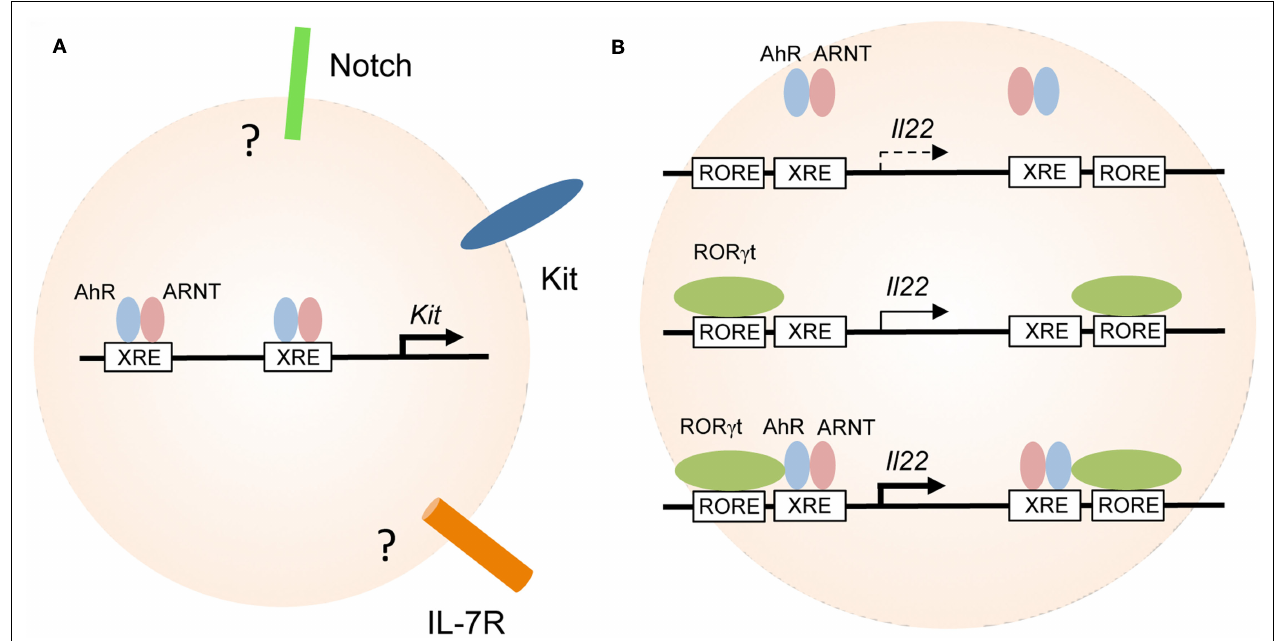
FIGURE 2 |Aryl hydrocarbon receptor transcriptionally controls the expression of Kit and IL-22. (A) Regulation of genes involved in the maintenance of ROR γ t + ILC. AhR-deficiency leads to reduced expression of Kit, IL-7R, Notch, and antiapoptotic molecules all of which have been implicated in the maintenance and/or survival of ROR γ t + ILC. AhR directly binds to the two XRE elements of the Kit promoter and induces its